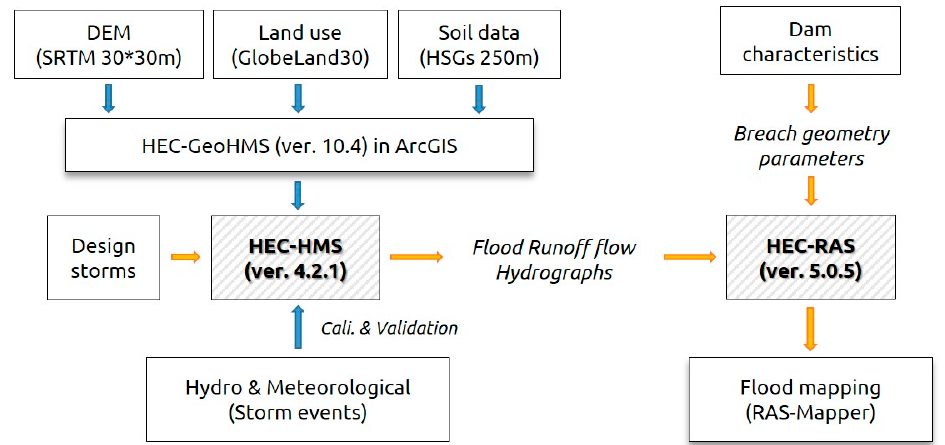
Figure 2. Overall procedures of our modeling work.